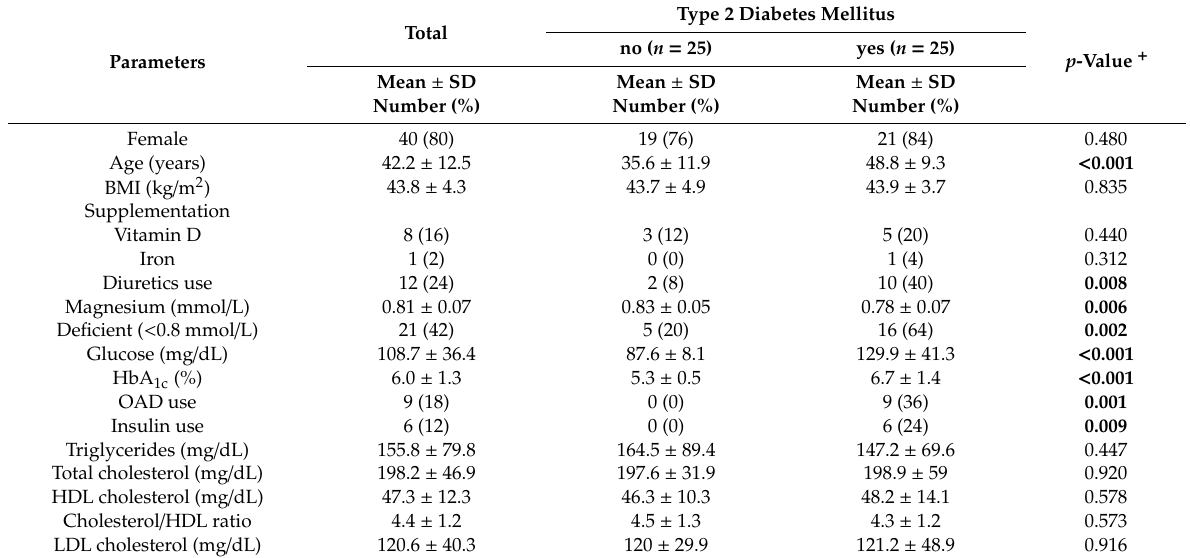
Table 1. Patients’